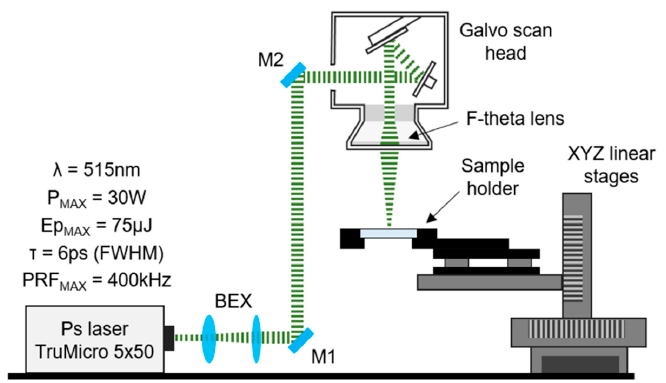
Figure 1. Schematic of the laser system used for machining of the glass plate.